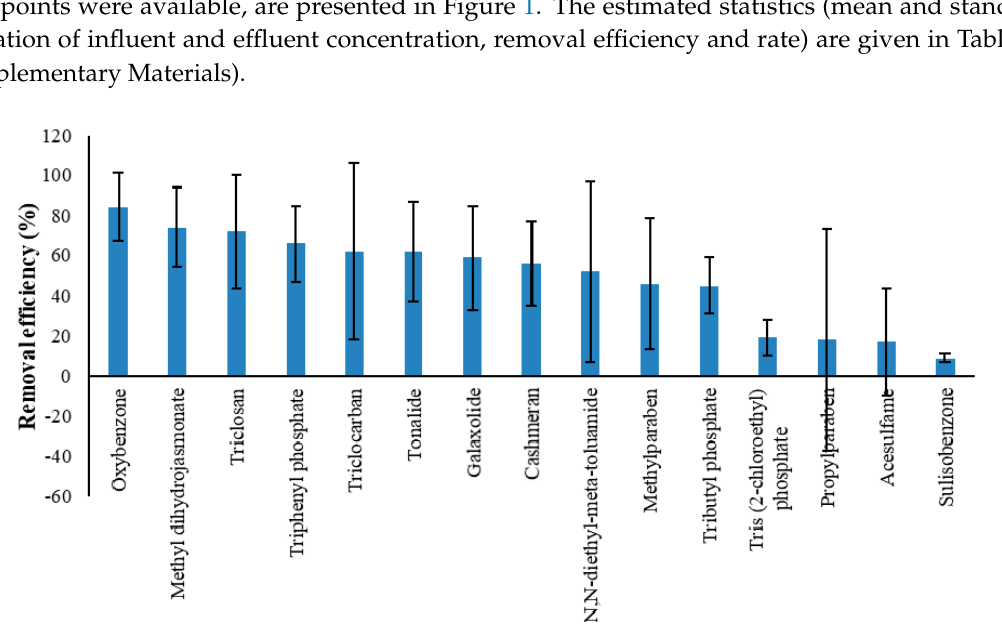
Figure 1. Removal efficiency of widely investigated PCPs. Note: the statistics are for 15 Figure 1. Removal e ffi ciency of widely investigated PCPs. Note: the statistics are for 15 PCPs with PCPs with three or more data points. three or more data